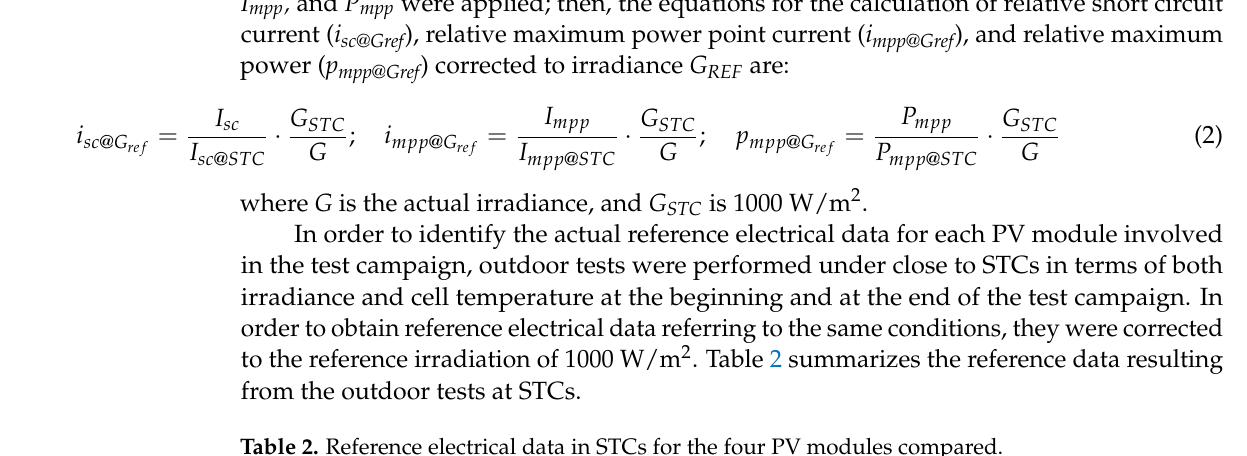
Table 2. Reference electrical data in STCs for the four PV modules compared.